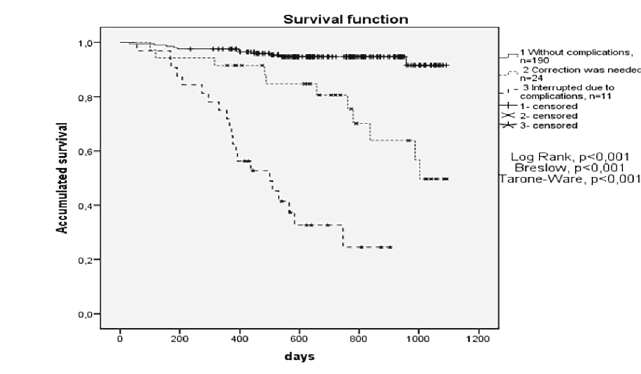
Figure 4 - Kaplan-Meier survival curves on the successfulness of chemotherapy courses